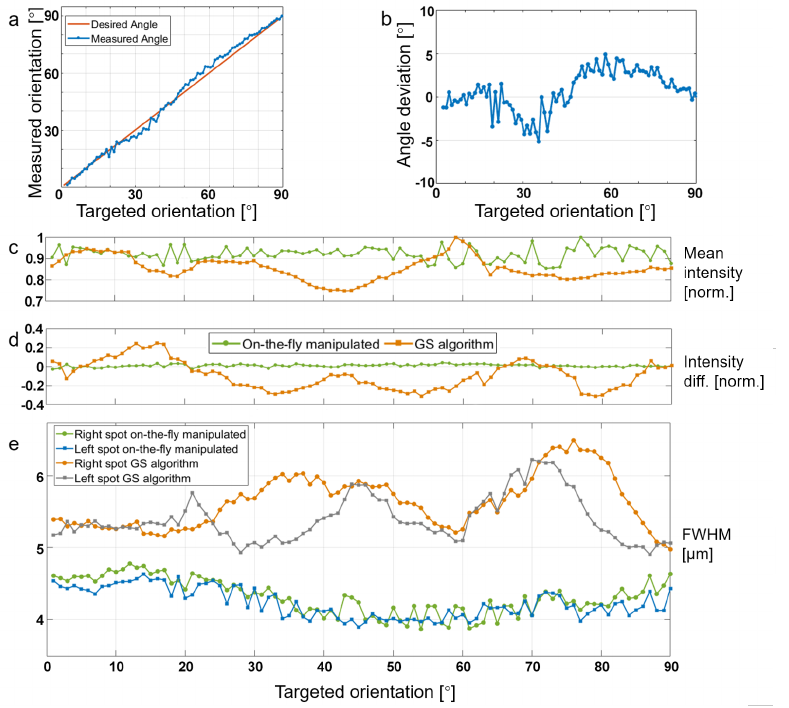
Figure 8. Analysis of the experimental rotation of the fiber output dual-spot profile from 0 ◦ to 90 ◦ in 1 ◦ -steps. ( a ) Comparison of the desired and the experimental rotation angle of the dual-spot. (blue-experimental rotation angle; red-desired rotation angle). ( b ) The deviation between the desired and experimental rotation angle, while the mean deviation is 1.9 ◦ and the maximum deviation is 5.1 ◦ . ( c ) Comparison of normalized mean intensity at various rotation angles employing Core-GS algorithm with and without on-the-fly manipulation. The standard deviation of the mean intensity decreased from 5.5% to 3.2% and the maximum deviation from 14.5% to 7.9% with the on-the-fly manipulation. ( d ) Normalized difference between the mean intensity of the two spots (background noise removed). The mean intensity difference strongly dropped from 14.9% to 1.4% and the maximum difference from 24.6% to 4.1% with the on-the-fly manipulation. ( e ) Full width half maximum (FWHM) of each spot with and without on-the-fly manipulation at different orientations. The standard deviation of the FWHM of the right spot optimized from 0.37 µ m to 0.24 µ m, and for the left spot from 0.32 µ m to 0.2 µ